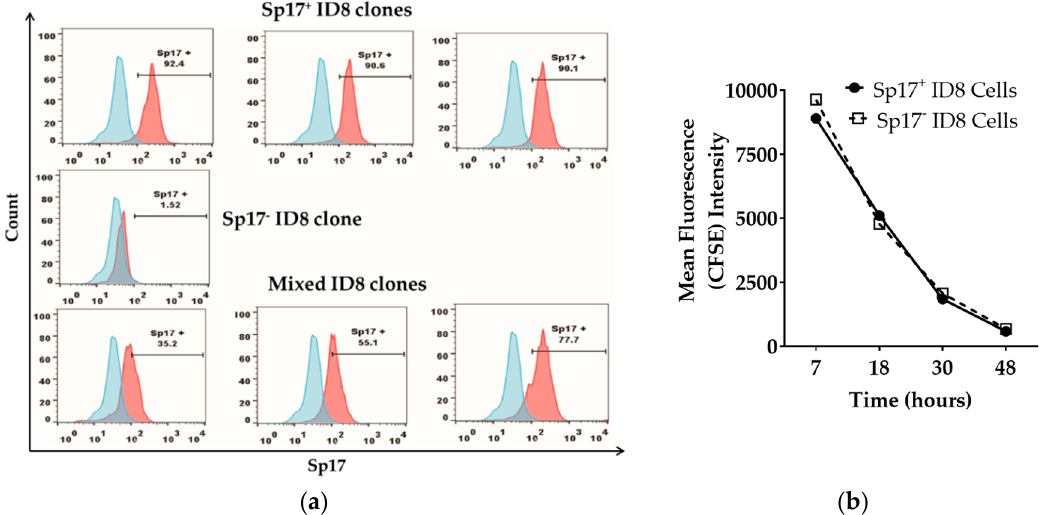
Figure 1. Sperm protein 17 (Sp17) is expressed in a subset of ID8 cells in vitro. ( a ) Sp17 expression in selected ID8 sub-clones: Sp17 + (top panel, three sub-clones obtained), Sp17 − (middle panel, one sub-clone obtained), and mixed clones (bottom panel, three representative sub-clones), analyzed by flow cytometry. Data is shown as histogram of Sp17 expression (red) over isotype control (blue) for each of the ID8 sub-clone presented here. The X -axis shows the fluorescence intensity and the Y -axis shows count. All cells were stained intracellularly with an anti-Sp17 antibody; ( b ) in-vitro growth of the Sp17 + and Sp17 − ID8 cells. The Sp17 + and Sp17 − cloned ID8 cells were stained by carboxyfluorescein succinimidyl ester (CFSE) and cultured for 7, 18, 30, and 48 h. CFSE fluorescence was assessed by flow cytometry at each time point.